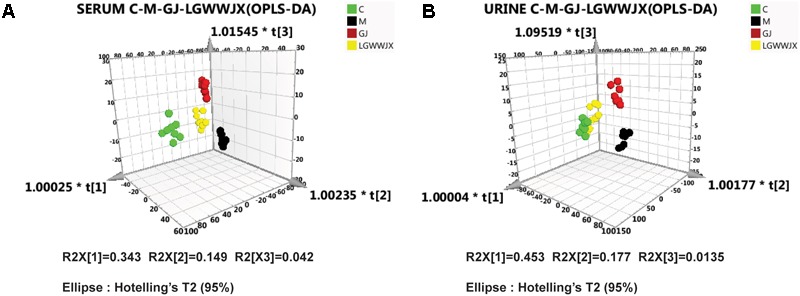
OPLS-DA scores 3D plots. (A) Comparison of C (green), M (black), GJ (red), and LGWWJX (yellow) in serum (R2X = 0.855, R2Y = 0.896, Q2 = 0.659). (B) Comparison of C (green), M (black), GJ (red), and LGWWJX (yellow) in urine (R2X = 0.817, R2Y = 0.899, Q2 = 0.639).